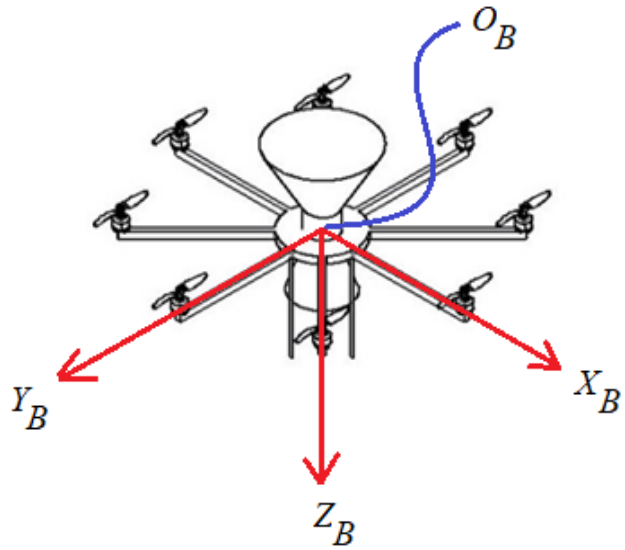
Figure 7. Illustration of body frame. The origin ( O B ) of the frame was placed at the center of mass of the octocopter. The X -axis ( X B ) is pointing forward along the